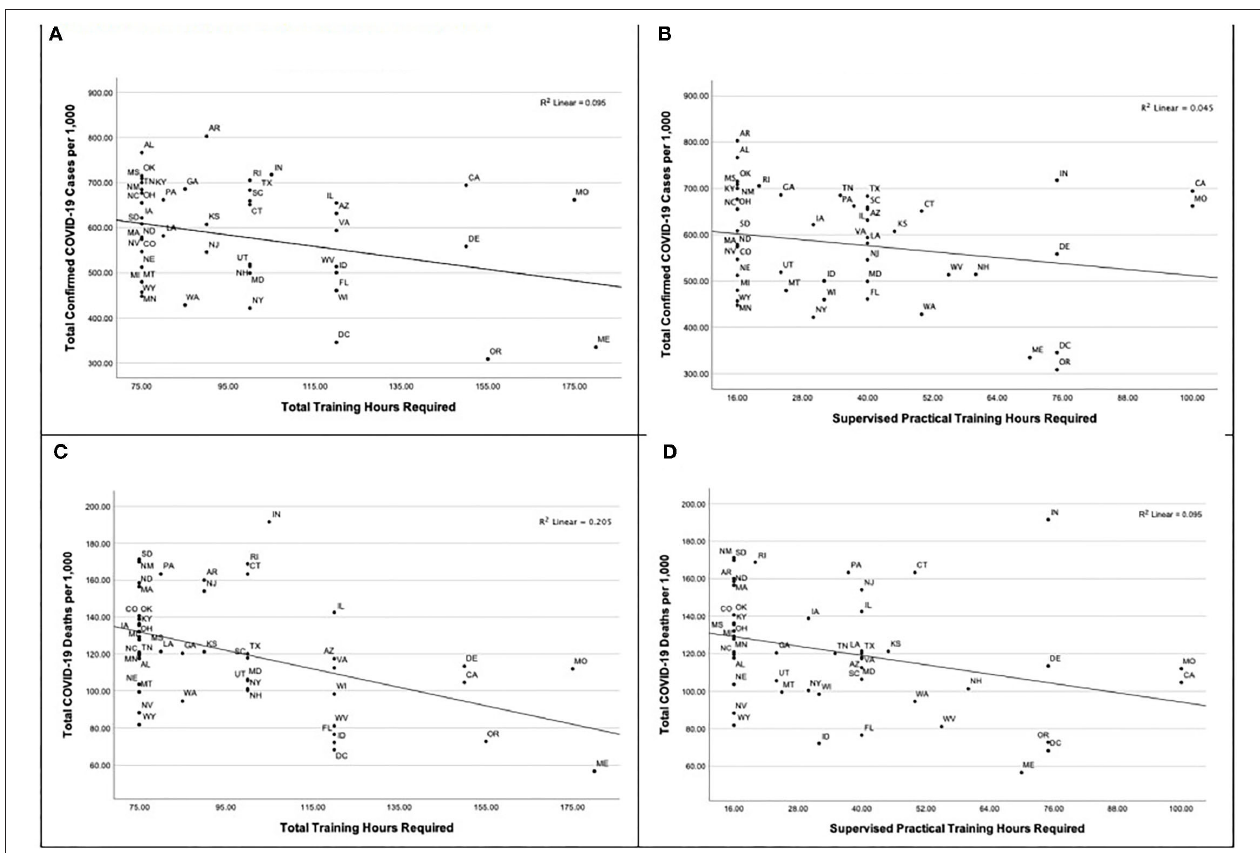
FIGURE 1 | Association between State Training Requirements for Certified Nurisng Assistants and State Average Nuring Home Resident COVID-19 Infection and Death Rates, 01.01.2022 – 02.07.2021. (A) Association between state-required total training hours and nursing home resident COVID-19 infection rates, (B) Association between state-required supervised practical training hours and nursing home resident COVID-19 infection rates, (C) Association between state-required total training hours and nursing home resident COVID-19 death rates, (D) Association between state-required supervised practical training hours and nursing home resident COVID-19 death